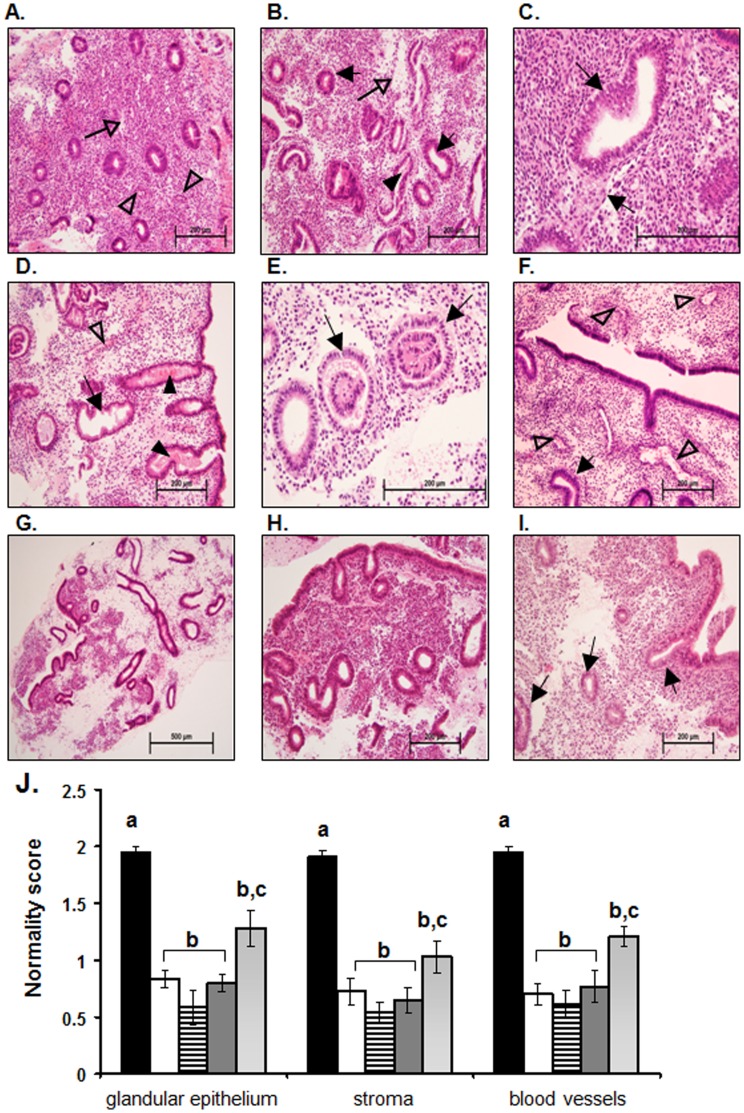
Endometrial histology of IVF stimulated and non-stimulated endometria.In the fertile non-stimulated endometrium at LH+2 (A) the glands are small and straight with only very early signs of secretory changes. The stroma is compact with minor signs of oedema (open arrow), and blood vessels are small (open arrow head). At hCG+2 in the fertile donor endometrium stimulated with GnRH agonist, (B & C) the glandular epithelial cells show secretory changes as evidenced by sub-nuclear vacuoles (C, closed arrows), some evidence of secretory activity can also be observed within the lumen of some endometrial glands (B, closed arrowhead). The stroma is expanded and oedematous (B, open arrow). At hCG+2 in the infertile endometrium stimulated with the GnRH antagonist protocol (D & E) a range of different endometrial cycle stage appearances presented. In some endometria (D) the endometrial glandular epithelial cells have lost their sub-nuclear vacuoles and are highly secretory (D, closed arrowheads) with glands becoming tortuous (D, arrow). The stroma is also highly oedematous and large open blood vessels are present (D, open arrowhead). Other infertile GnRH antagonist stimulated endometria (E) present with sub-nuclear vacuoles evident in the endometrial glands (E, arrows) and expanded stroma. In the endometria at hCG+2 of infertile women stimulated with the GnRH agonist protocol who did not subsequently become pregnant (F & G) a mixed picture of endometrial histology is observed. Sub-nuclear vacuoles are present in the endometrial glandular epithelial cells (F, closed arrow) with the presence of expanded oedematous stroma and large expanded blood vessels close to the luminal epithelium (F, open arrowheads). In other endometria from this group (G) the tissue histology is disturbed with highly developed, tortuous, secretory endometrial glands and highly oedematous stroma, with the tissue as a whole presenting a fragile appearance. In infertile women stimulated with the GnRH agonist protocol who subsequently became pregnant (H & I) fairly small compact endometrial glands with only early signs of secretory transformation (I, arrows) were observed at hCG+2. The stroma, while expanded in some areas is generally compact and the blood vessels are not highly developed. Endometrial histology was scored by means of a ‘normality score’ (J) with tissues of normal histology for LH+2 allocated a score of 2, tissues with somewhat changed histology allocated a score of 1 and tissues with highly altered histology allocated a score of 0. Data for fertile women are presented in black (?), data for fertile donors are presented in white (□), data for infertile GnRH antagonist are presented in horizontal lines (≡), data for infertile GnRH agonist not pregnant are presented in dark grey (?), data for infertile GnRH agonist pregnant are presented in light grey (?). Data are presented as mean ± SEM. a is significantly different from b, p<0.01; b is significantly different from c, p<0.05.